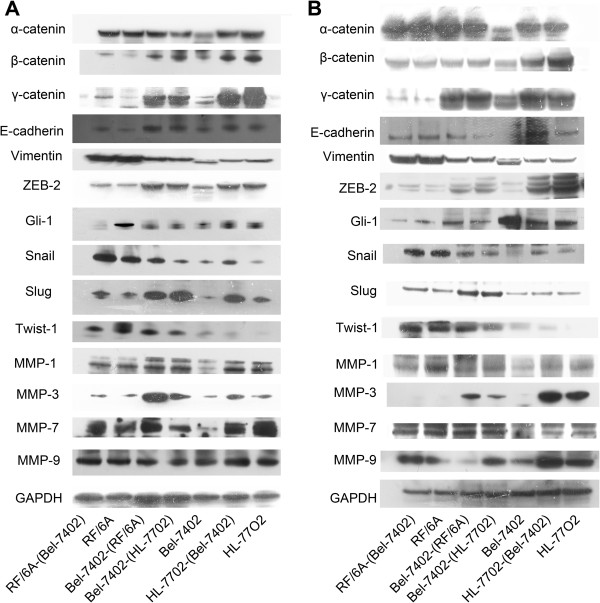
Epithelial and mesenchymal marker expression. Western blot analysis of Bel-7402 cells co-clutured with HL-7702 or RF/6A cells for 28 days (A) and 44 days (B).